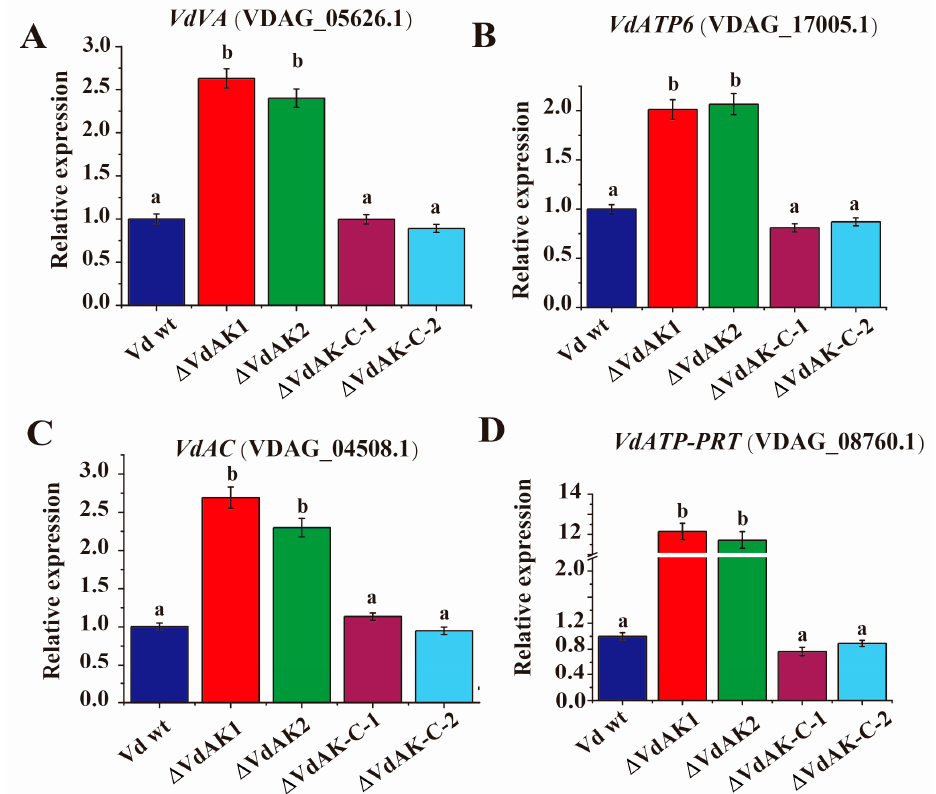
Figure 5. Relative expression of fungal genes associated with energy metabolism in Δ VdAK , Δ VdAK-C, and wild-type Vd (Vd wt) strains. Strains were cultured in complete medium (CM) broth for 7 days. Transcript levels of VdVA ( A ), VdATP6 ( B ), VdAC ( C ), and VdATP-PRT ( D ). Mean (± SE) levels from three independent experiments that differed significantly in Duncan’s test ( p <0.05) are indicated by different letters.